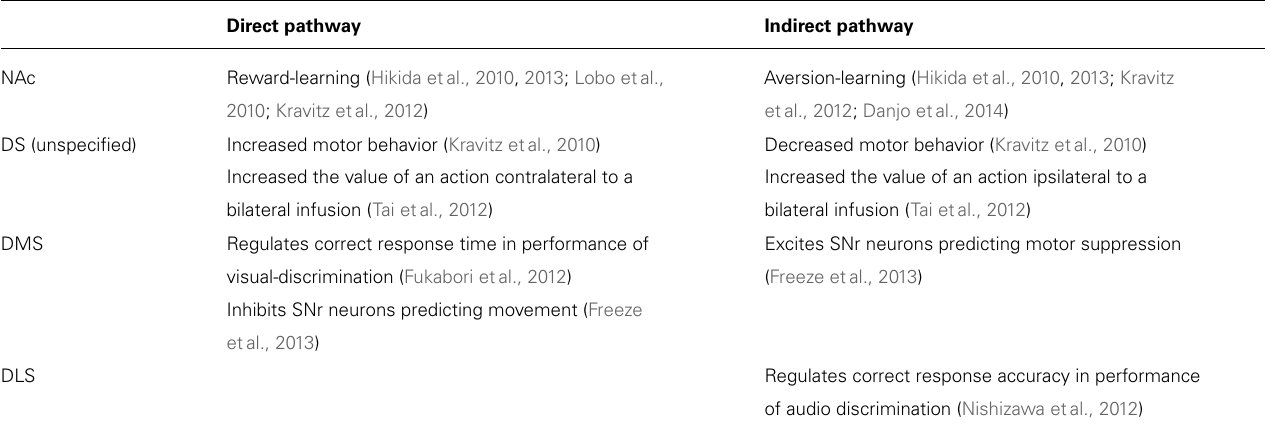
Table 1 | Effects of cell-specific genetic manipulation of direct and indirect pathway neurons within different striatal regions. Direct